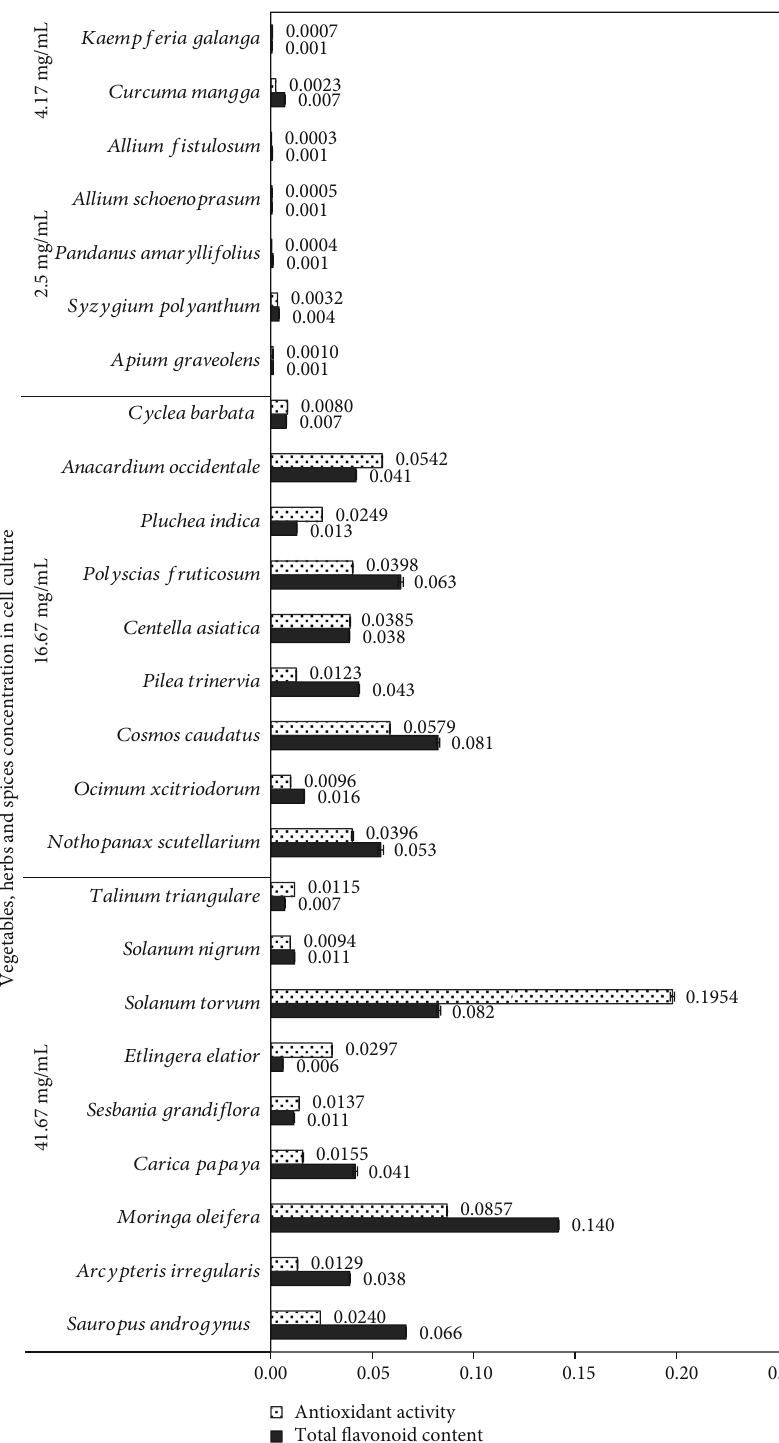
Figure 3: Total fl avonoid content (mg QE/mL) and antioxidant activity (mg AAE/mL) of 25 select vegetables, herbs, and spices in cell culture ( n = 3 , error bars represent standard